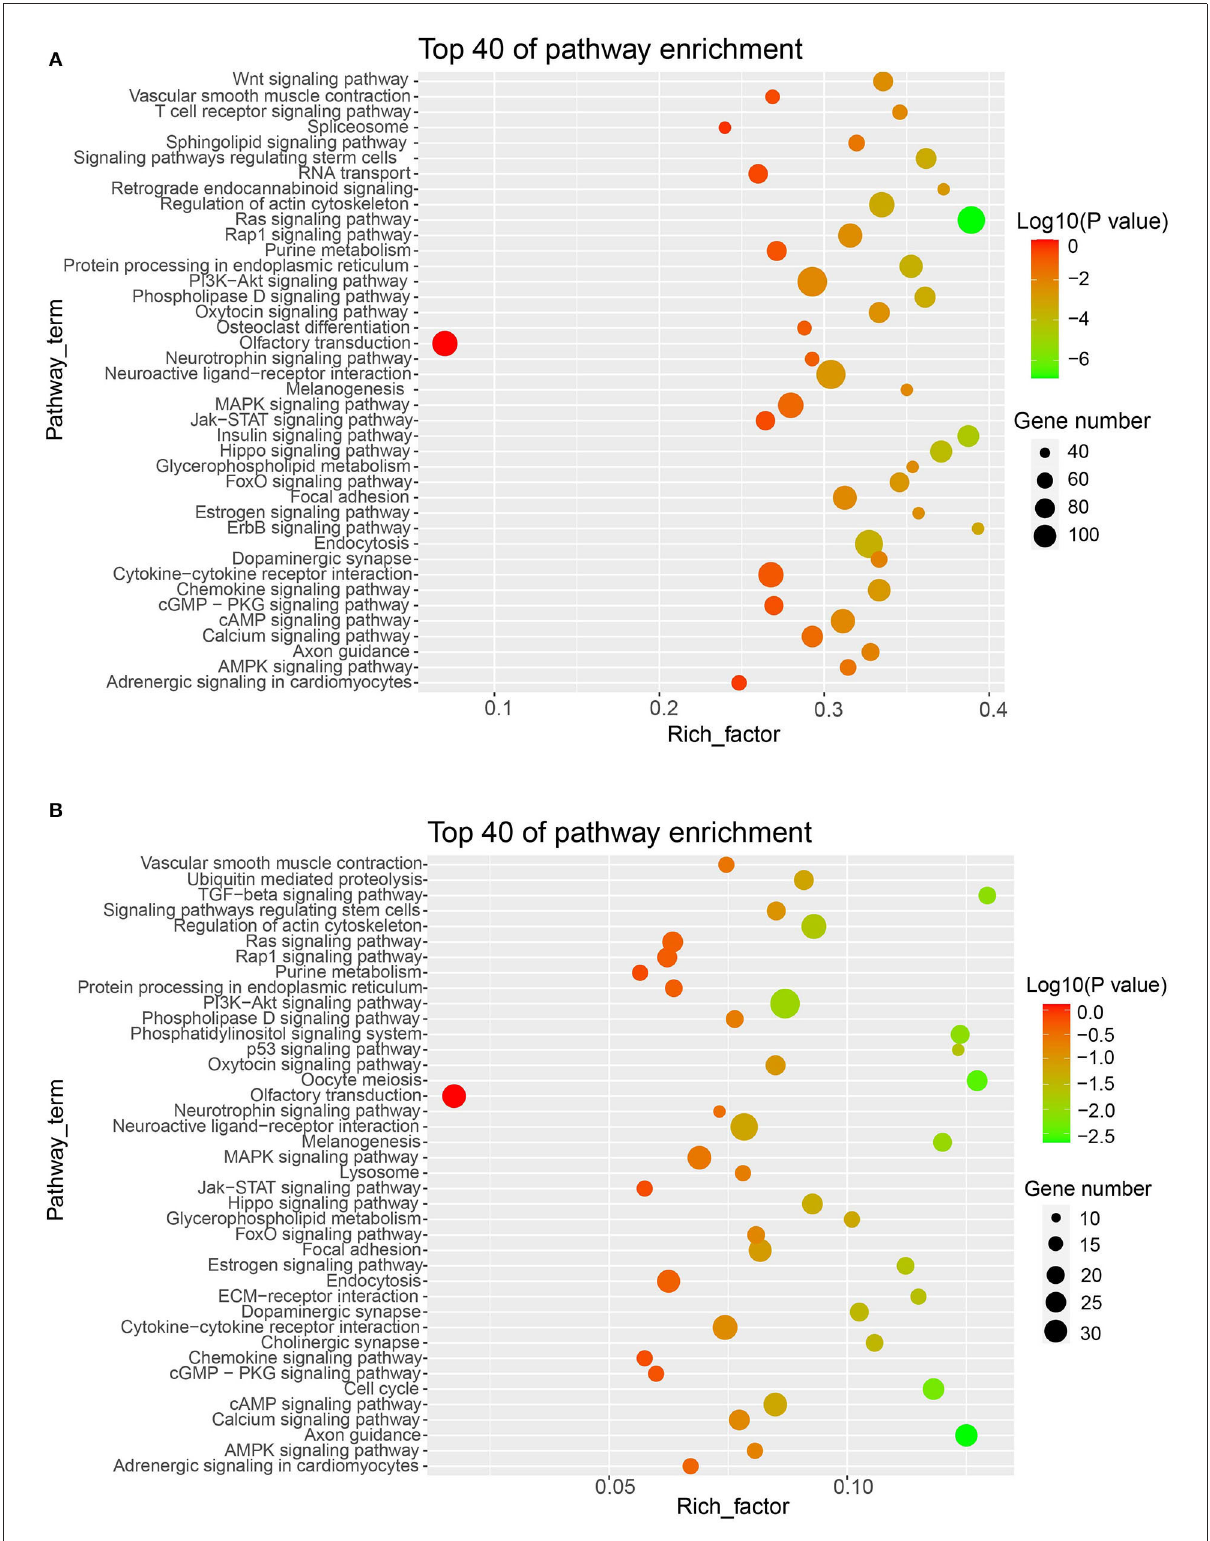
FIGURE7 Top 40 of KEGG enrichment of the up-up regulated target mRNAs (A) and the down-down regulated target mRNAs (B) in LP vs. FP.